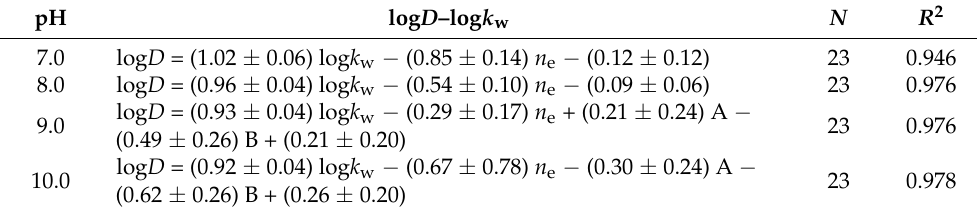
Table 3. Multi-parameter QSRR models derived from the 23 model